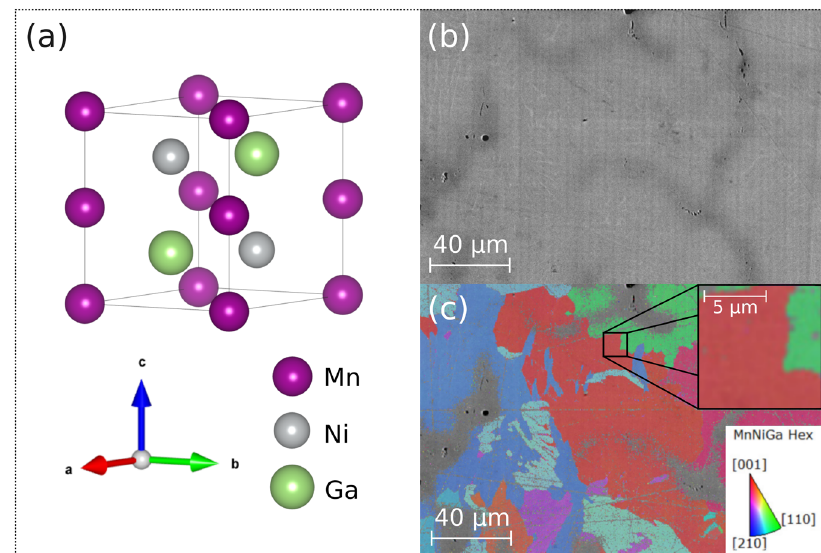
Fig. 9 MnNiGa sample characterization. a MnNiGa crystal structure with plotted hexagonal unit cell. The magnetic easy axis lies parallel to the c -axis. Scanning electron microscopy (SEM) micrographs showing: ( b ) Secondary electron contrast. Black shaded regions refer to locations with bad crystal quality on the surface. c Electron backscatter diffraction (EBSD) map with color-coded inverse pole fi gure contrast perpendicular to the surface. The inset shows the 10 × 10 µ m 2 region of interest being selected for quantitative magnetic force microscopy (qMFM) mapping. Images were acquired using a Bruker e - Flash HR detector